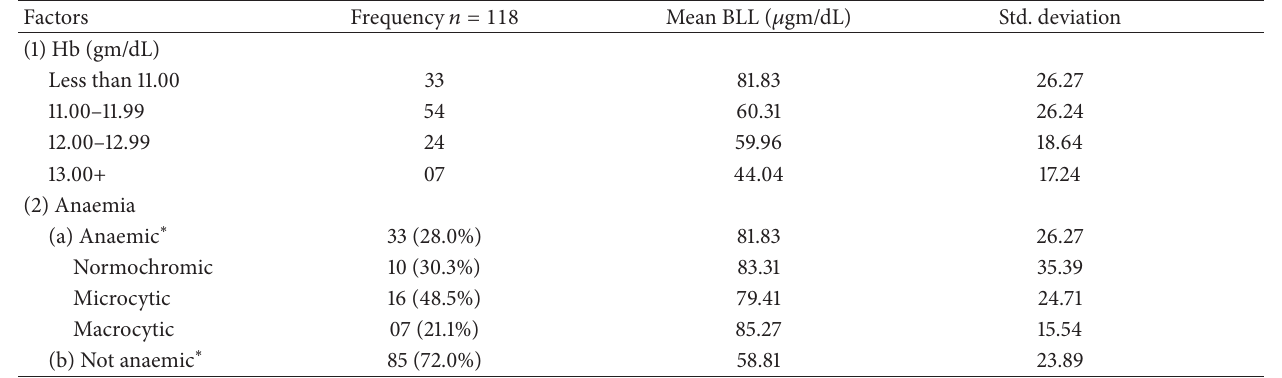
Table 4: Mean BLL, haemoglobin (Hb) level, and anaemic status of the workers.